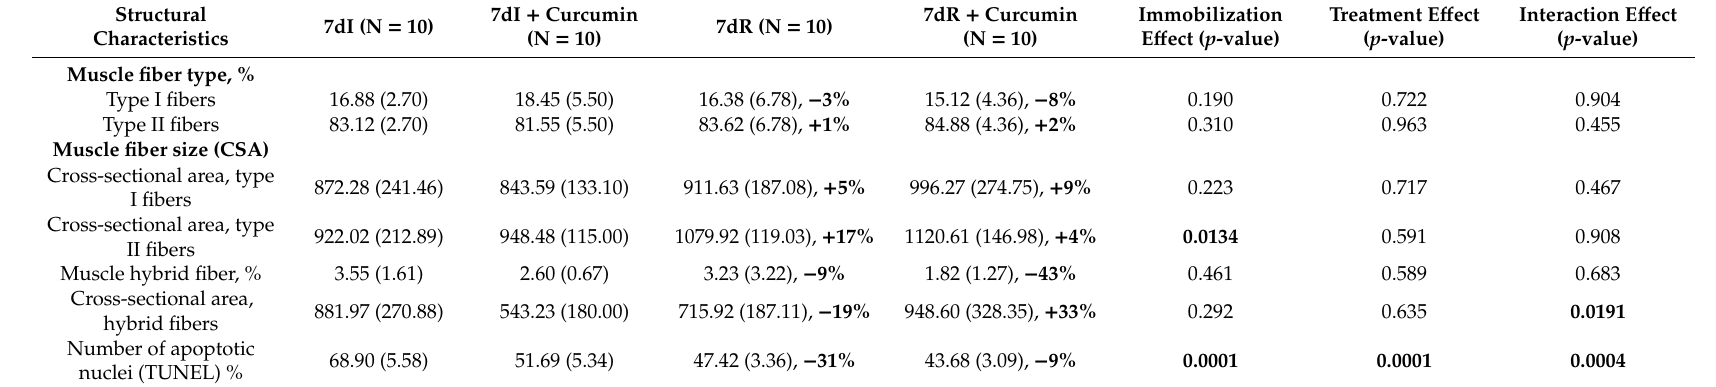
Table 2. Structural characteristics of the gastrocnemius muscle in the study